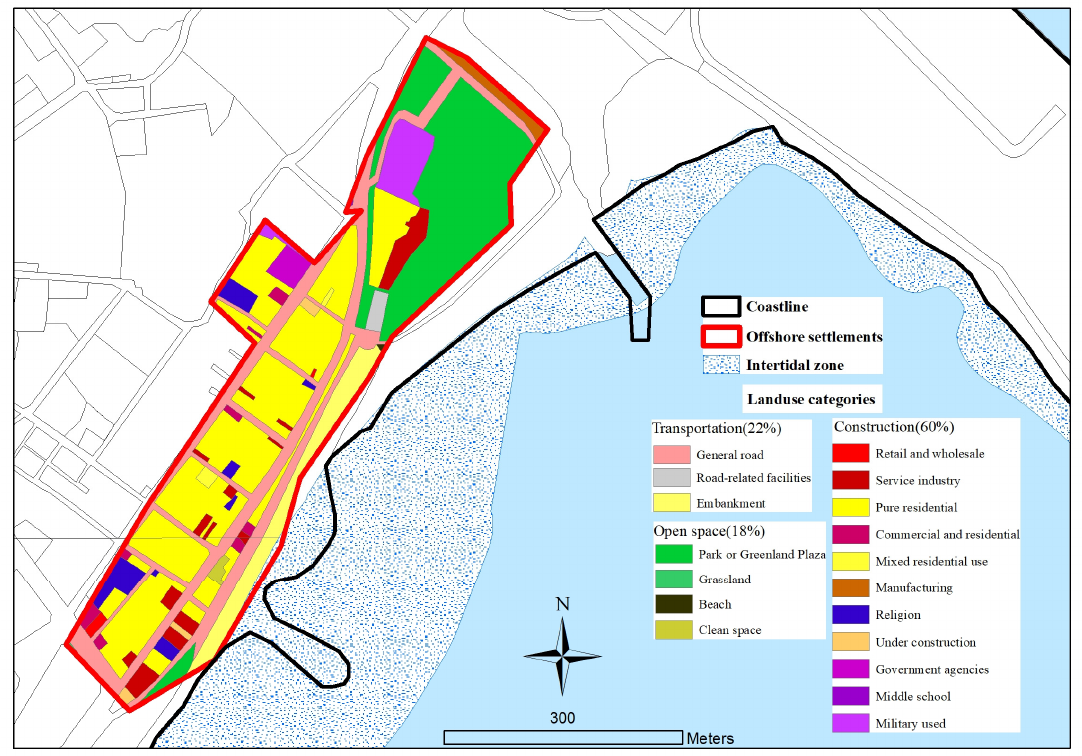
Figure 2. Land-use category area distribution within the settlement area.